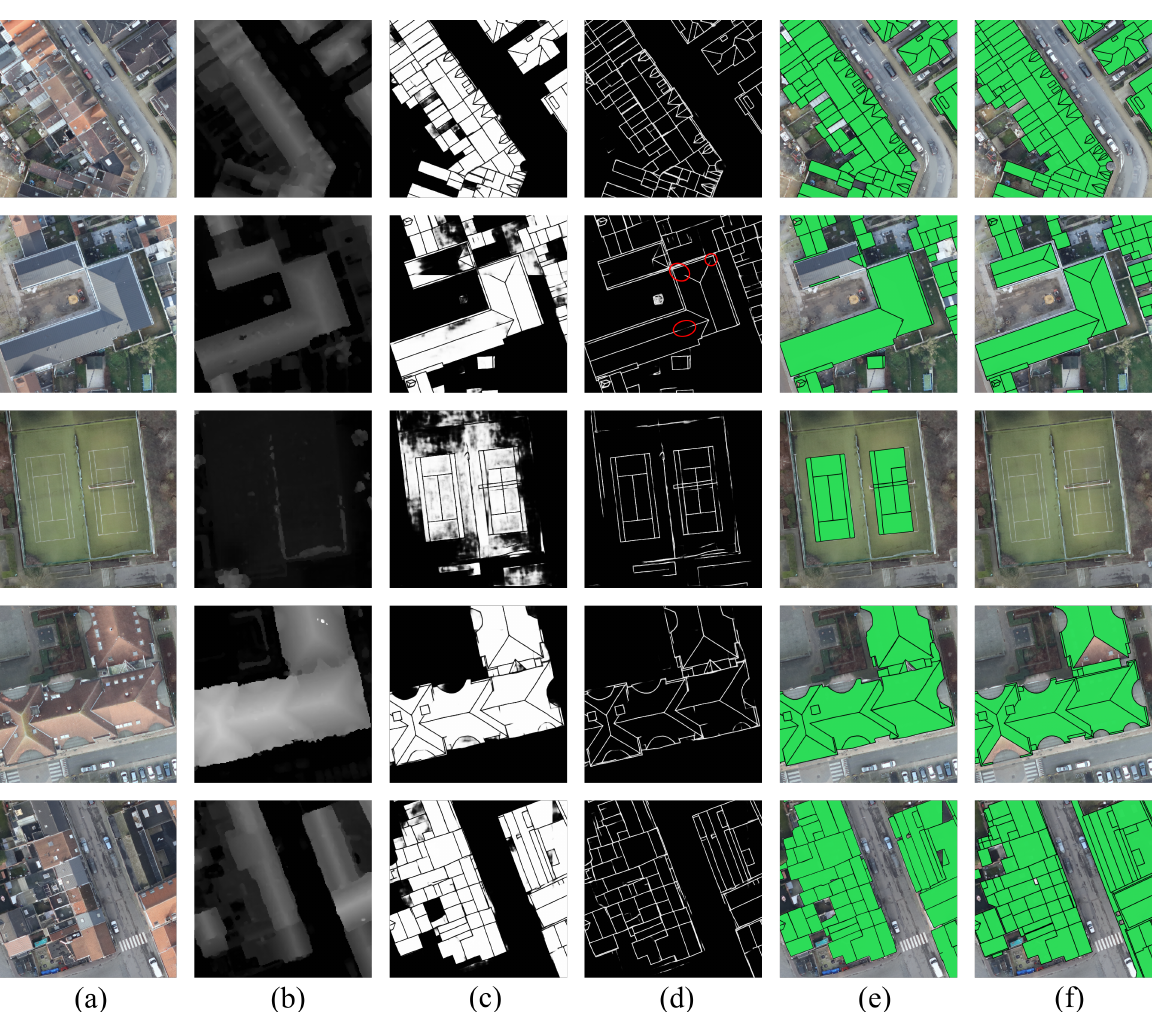
Figure 9. Illustrative results from the test set. Patches were 50 by 50 m (1667 × 1667 pixels). ( a ) RGB image. ( b ) DEM image. ( c ) Predicted roof-part objects. ( d ) Predicted roof-part edges. ( e ) Predicted roof-part polygons. ( f ) Ground